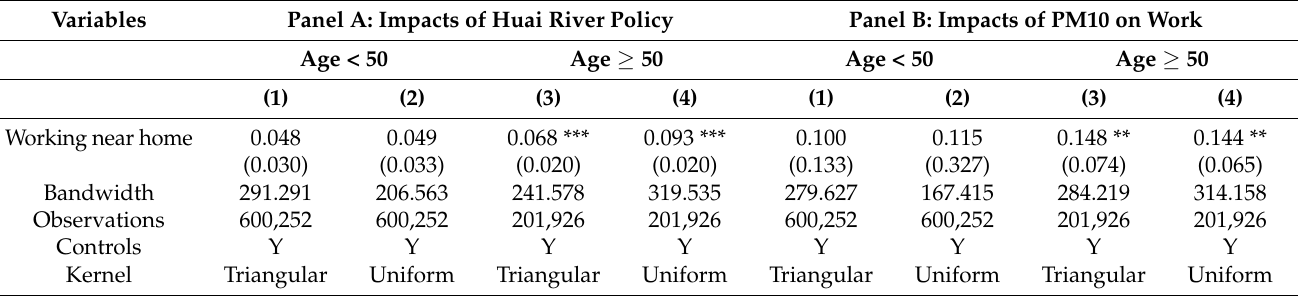
Table 5. The impacts of PM 10 on work by